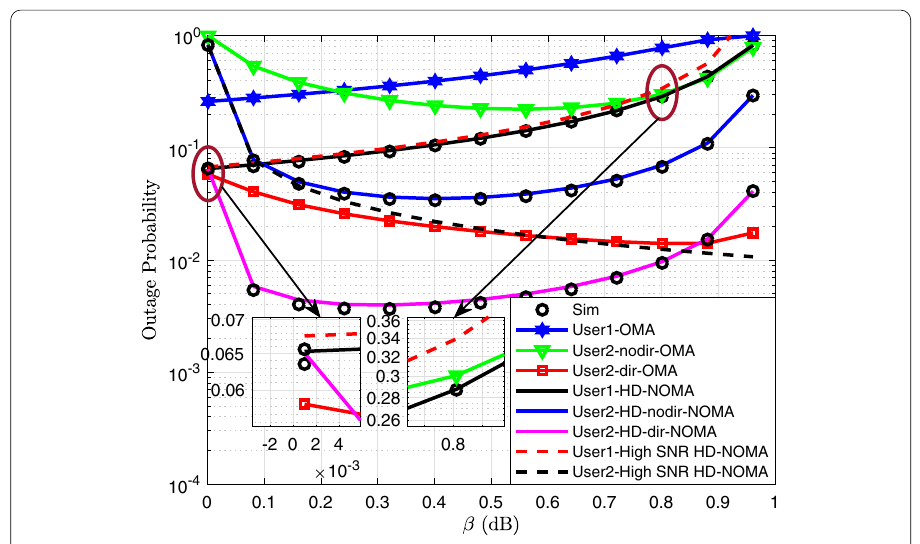
Fig. 4 Outage probability of two users versus β in case of no direct link and direct